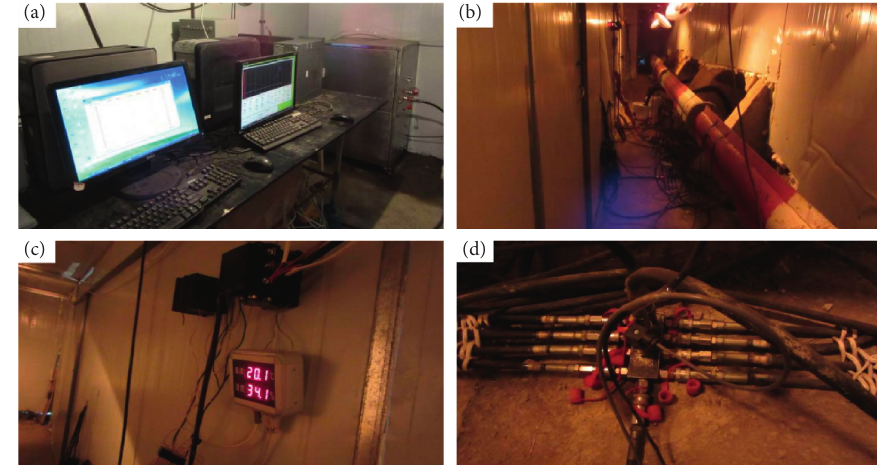
Figure 7: (a) Loading system: data acquisition system, (b) site datum beam of model anchor, (c) temperature monitoring system, and (d) jack oil system of field loading